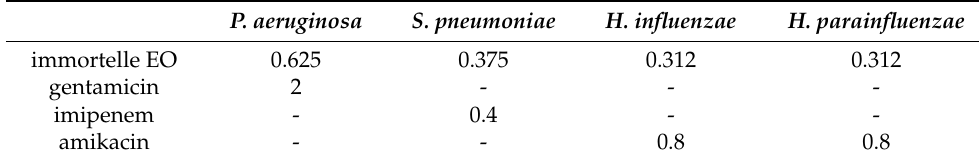
Figure 1. Biofilm degradation activity of immortelle EO against respiratory tract bacteria. The anti-biofilm activity was calculated and demonstrated in terms of inhibitory rate according to the equation: Inhibitory rate = (1 − S/C) × 100% (C and S were defined as the average absorbance of control and sample groups, respectively). Different lowercase letters (a, b, c) above boxes indicate significant differences at p ≤ 0.05. Table 2. The minimum inhibitory concentrations (MIC, mg/mL in case of essential oil; MIC: µ g/mL in case of antibiotics) of antibiotics and immortelle essential oil on respiratory tract